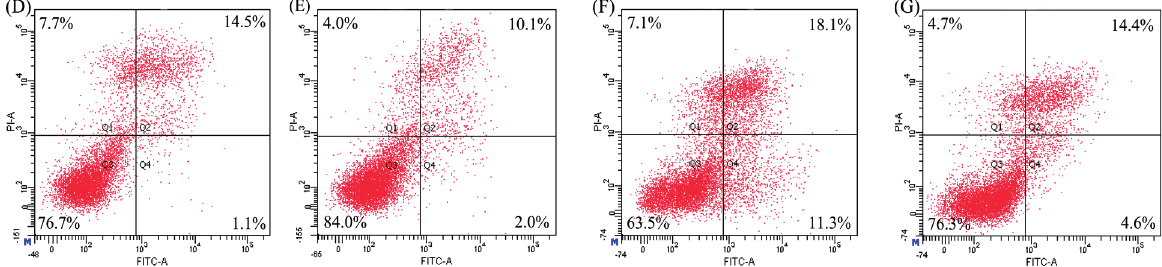
Figure 3. Apoptotic prevention of casein and soy protein hydrolysates (CH3 and SH3) at 0.05 mg/mL on etoposide- and NaF-induced apoptosis of hFOB1.19 cells. Cell apoptosis was measured by Annexin FITC-V/PI double-stained flow cytometry. Q1, dead cells; Q2, later apoptotic cells; Q3, viable cells; Q4, early apoptotic cells. ( A ) The cells in the control group; ( B , C ) The cells treated by etoposide and NaF, respectively; ( D , F ) The cells first treated by CH3 and SH3, respectively, and then by etoposide; and ( E , G ) The cells first treated by CH3 and SH3, respectively, and then by NaF. The labeled data were obtained from one assaying only. Table 2. Anti-apoptosis of casein and soy protein hydrolysates (CH3 and SH3) towards